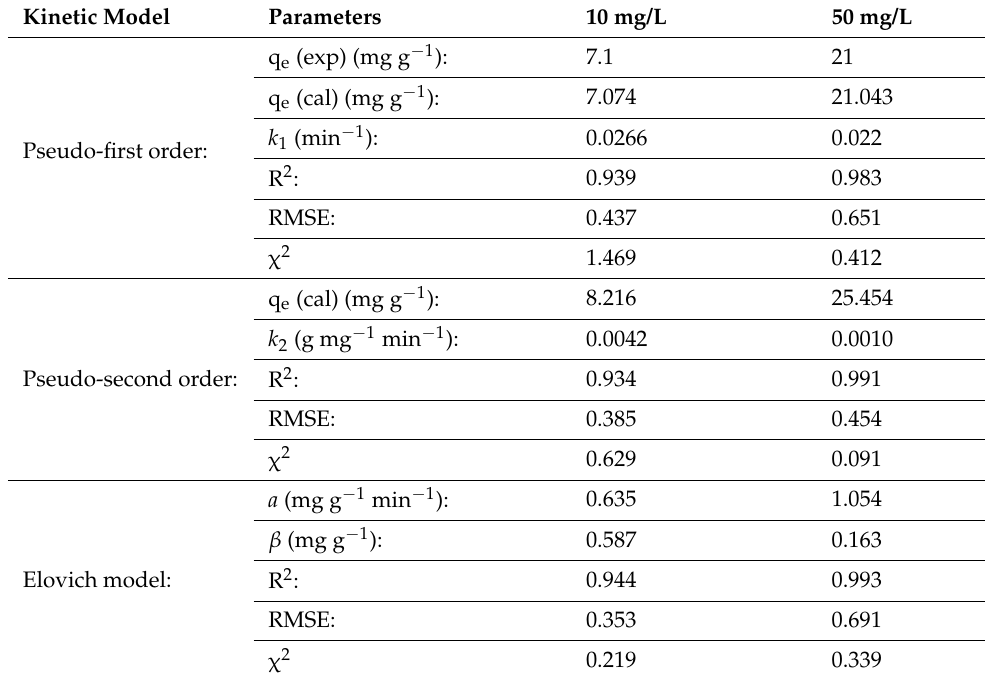
Table 1. The values of adsorption kinetics parameters for OTC onto Ni 3 S 4 /Ag 2 S/TiO 2 /CA